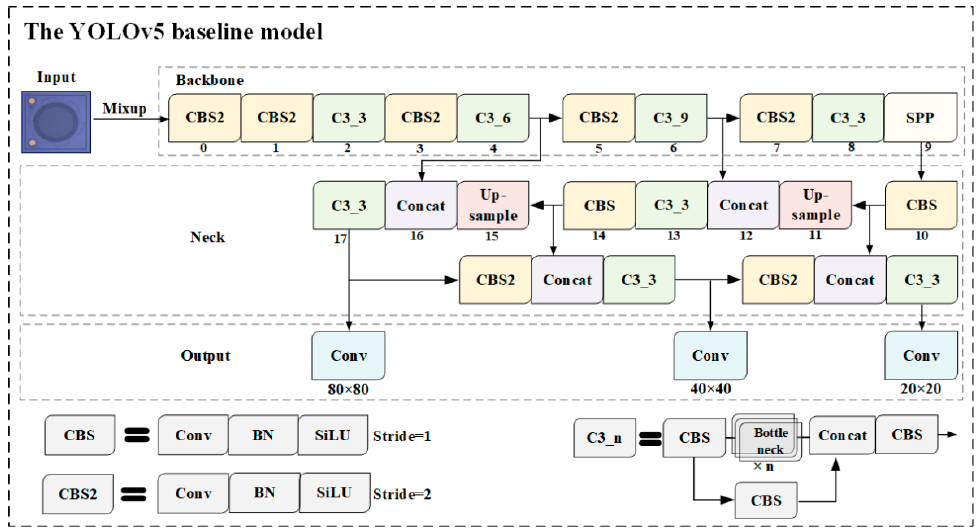
Figure 4. The network structure of the YOLOv5 baseline model.